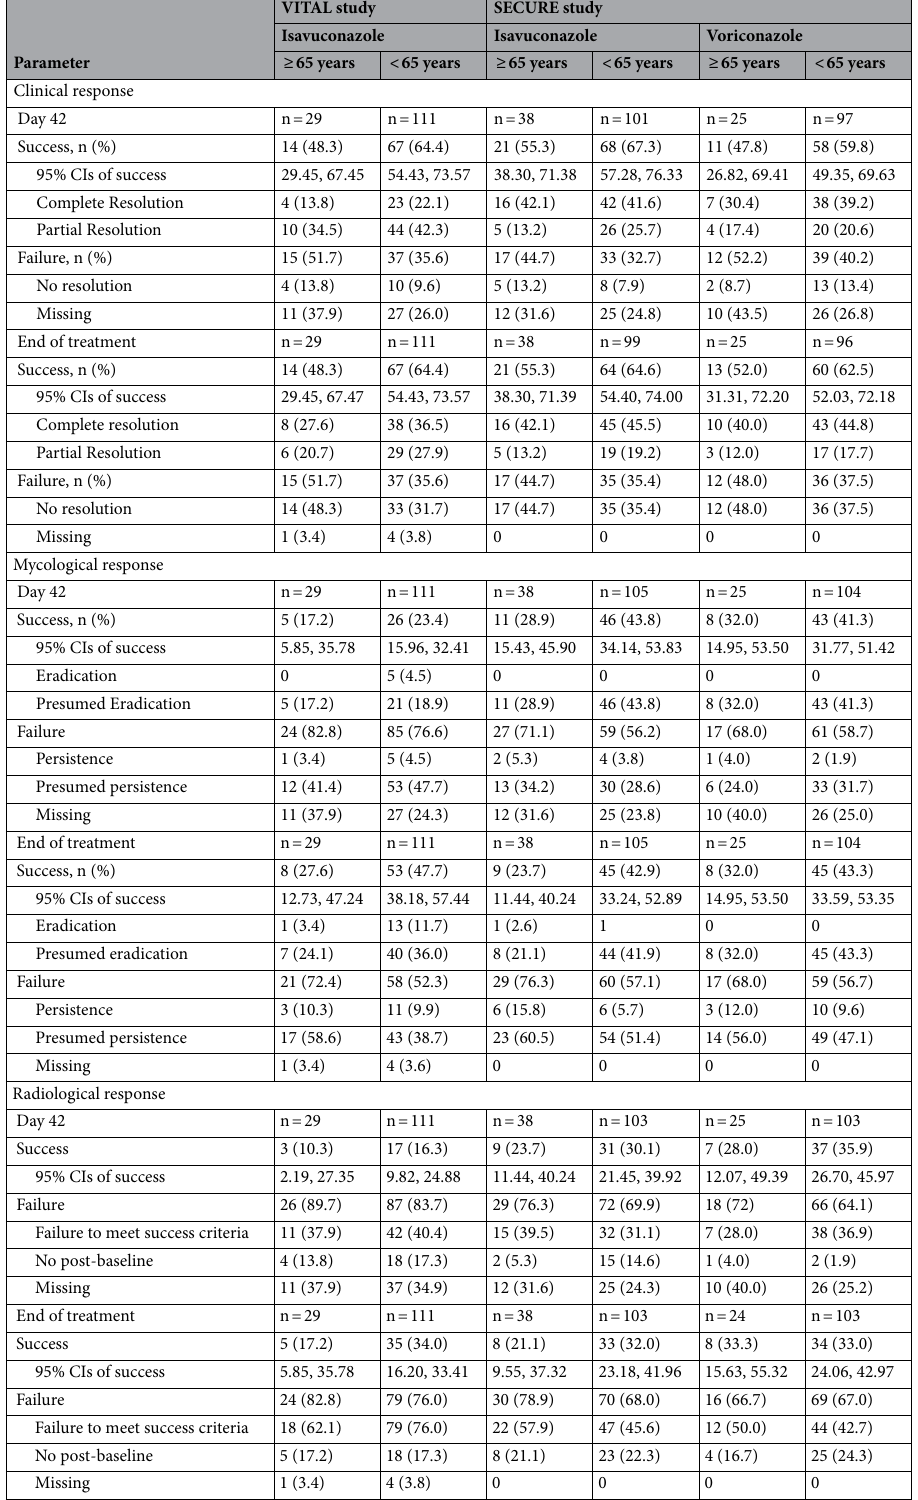
Table 7. DRC-assessed clinical response, mycological response, and radiological response (mITT population). Crude success rate is calculated within treatment. Complete and partial response referred to the resolution of attributable clinical symptoms and physical findings. Failure (no resolution) was defined as no resolution and/ or worsening of any attributable clinical symptoms and physical findings. No post-baseline: No post-baseline radiology available for patients with baseline evidence of radiologic disease. CI confidence interval, DRC data review committee, mITT modified ITT, n number of